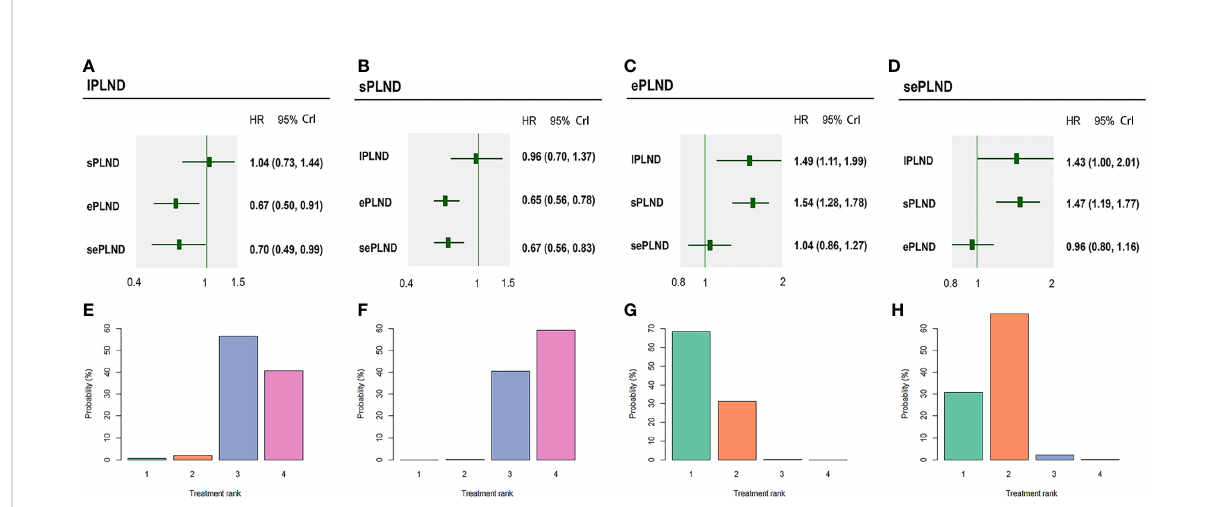
FIGURE 6 Bayesian network analysis results for RFS and rank probabilities of each PLND template based on the random effects model. (A) Other three PLND templates vs. lPLND template. (B) Other three PLND templates vs. sPLND template. (C) Other three PLND templates vs. ePLND template. (D) Other three PLND templates vs. sePLND template. (E) Probabilities of ranking the lPLND template in the fi rst, second, third and fourth place among four PLND templates. (F) Probabilities of ranking the sPLND template in the fi rst, second, third and fourth place among four PLND templates. (G) Probabilities of ranking the ePLND template in the fi rst, second, third and fourth place among four PLND templates. (H) Probabilities of ranking the sePLND template in the fi rst, second, third and fourth place among four PLND templates. RFS, Recurrence free survival. PLND, Pelvic lymph node dissection. HR, Hazard ratio. CrI, credible interval. lPLND, limited pelvic lymph node dissection. sPLND, standard pelvic lymph node dissection. ePLND, extended pelvic lymph node dissection. sePLND, super-extended pelvic lymph node